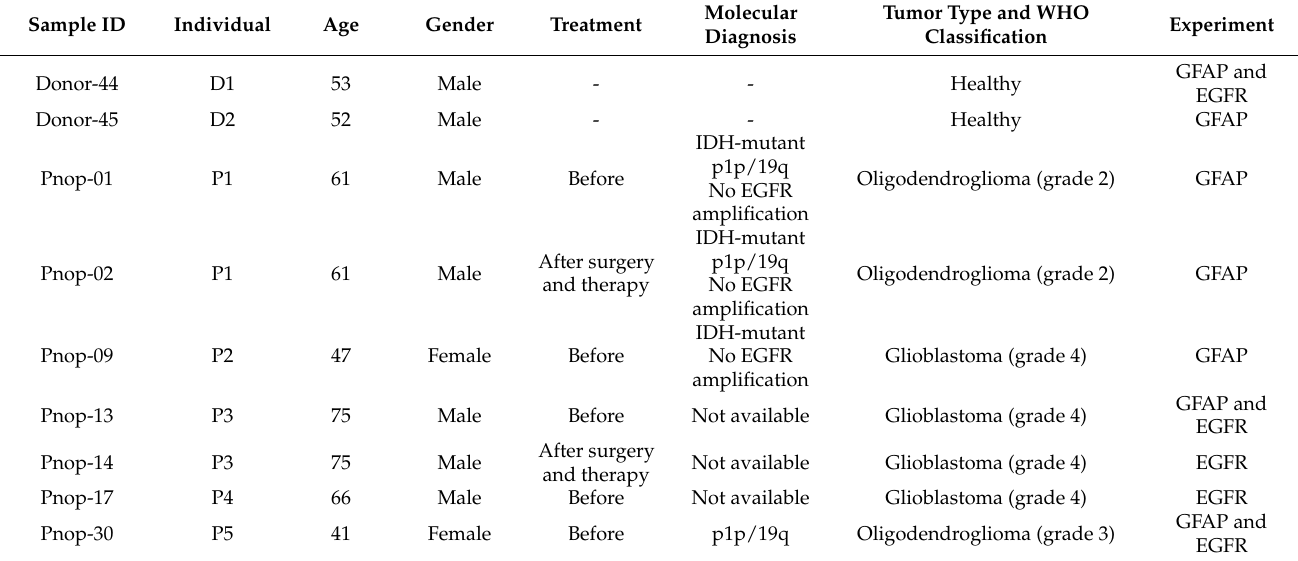
Table 1. List of plasma samples with clinical data and corresponding use in